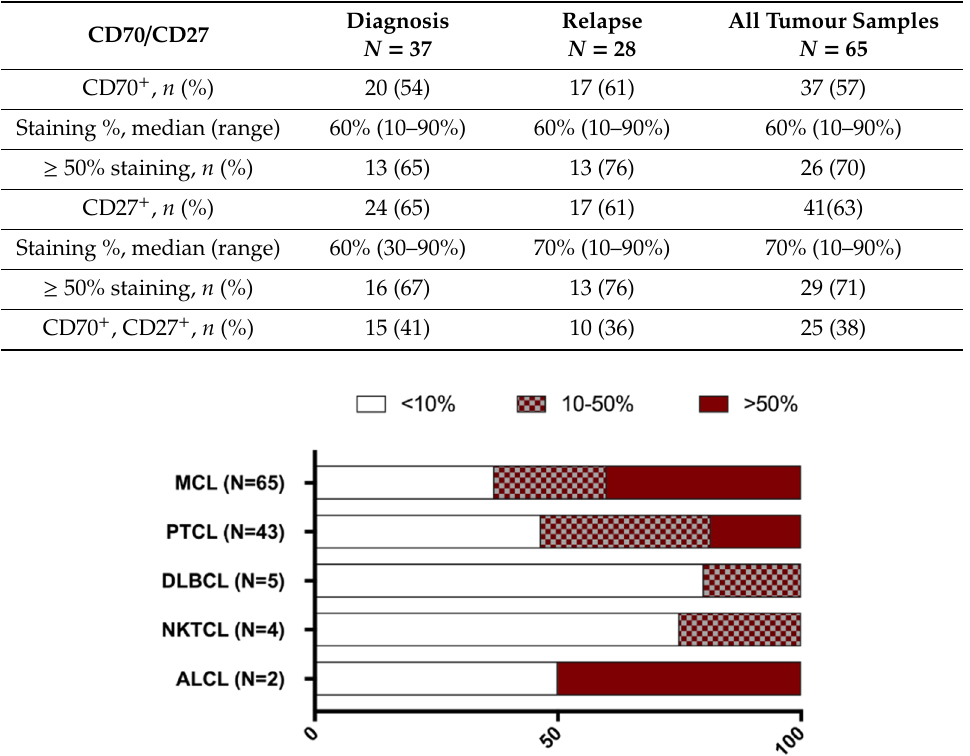
Table 1. CD70 and CD27 expression analysis in mantle cell lymphoma (MCL) samples.